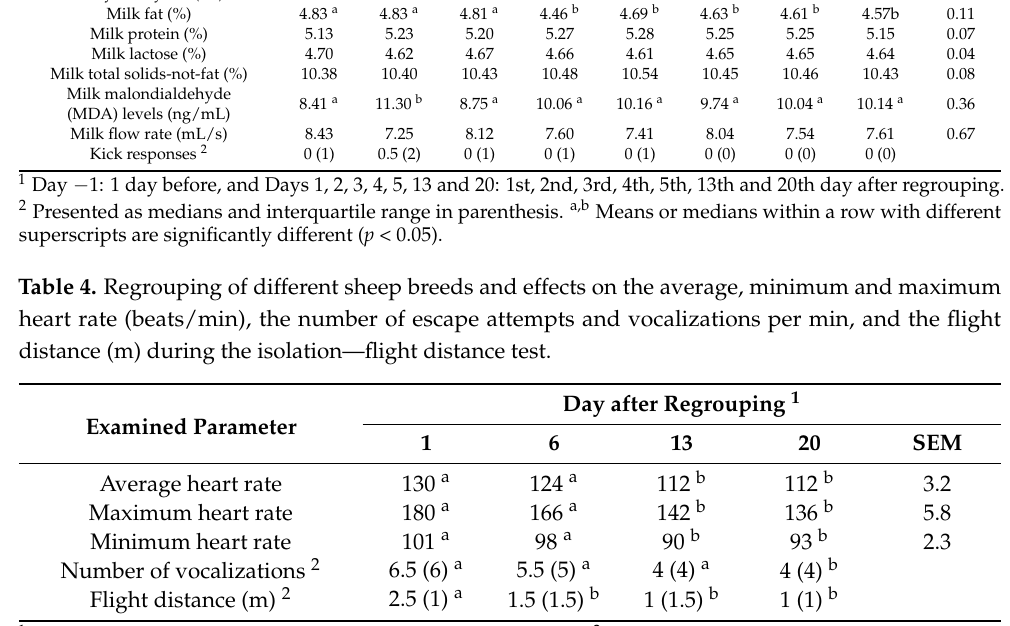
Table 3. Regrouping of different sheep breeds and effects on milk yield, composition, oxidative stability, flow rate and kick responses. Examined Parameter